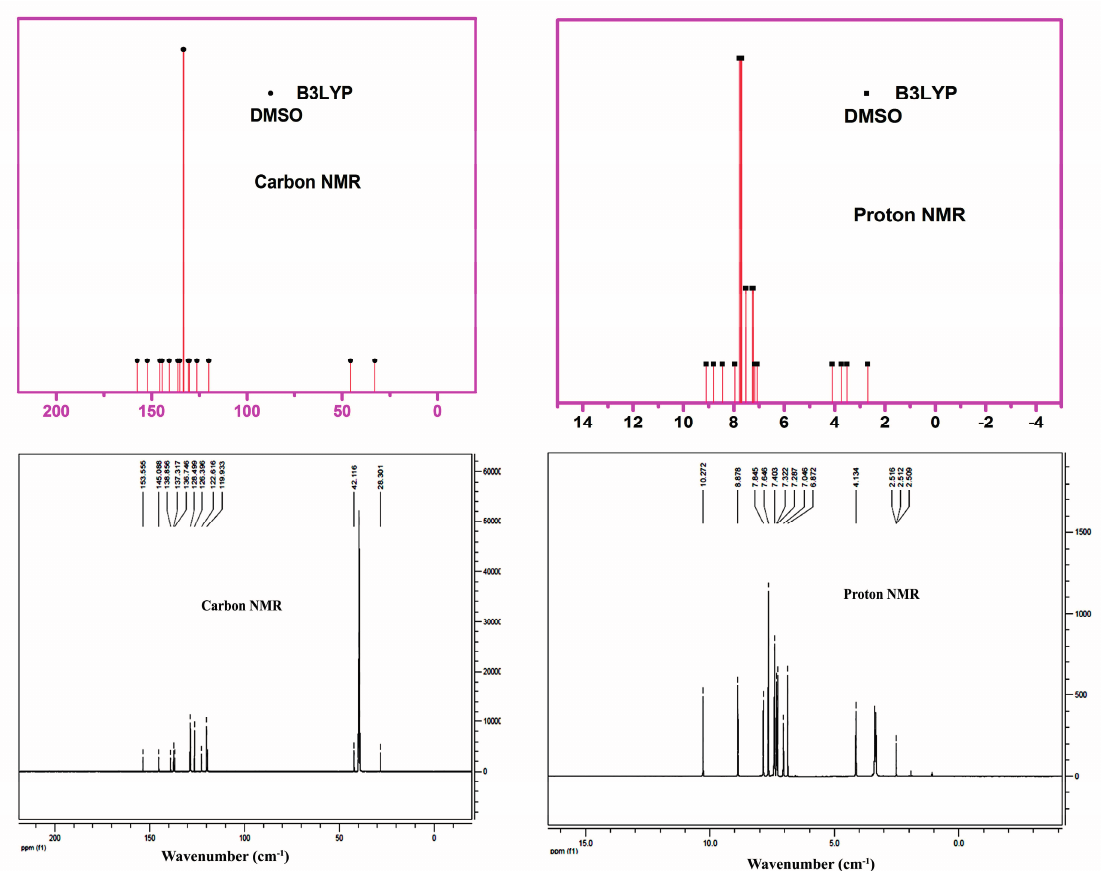
Figure 9. Theoretical and experimental 13 C and 1 H NMR of (2 E